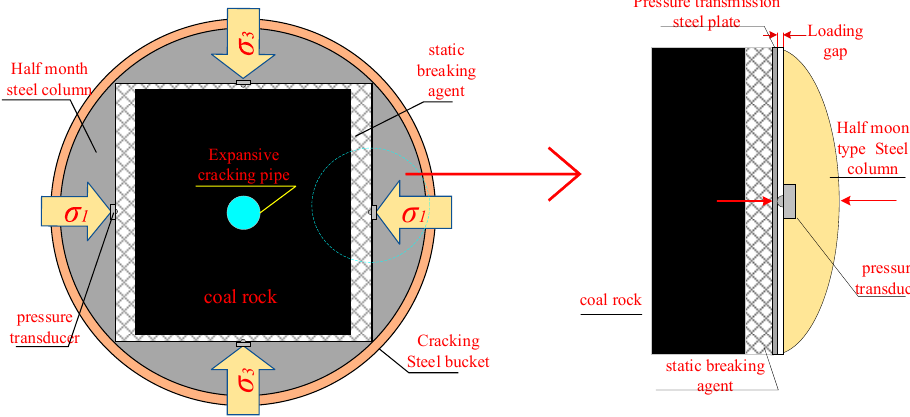
Figure 9. Mechanical microstructure.